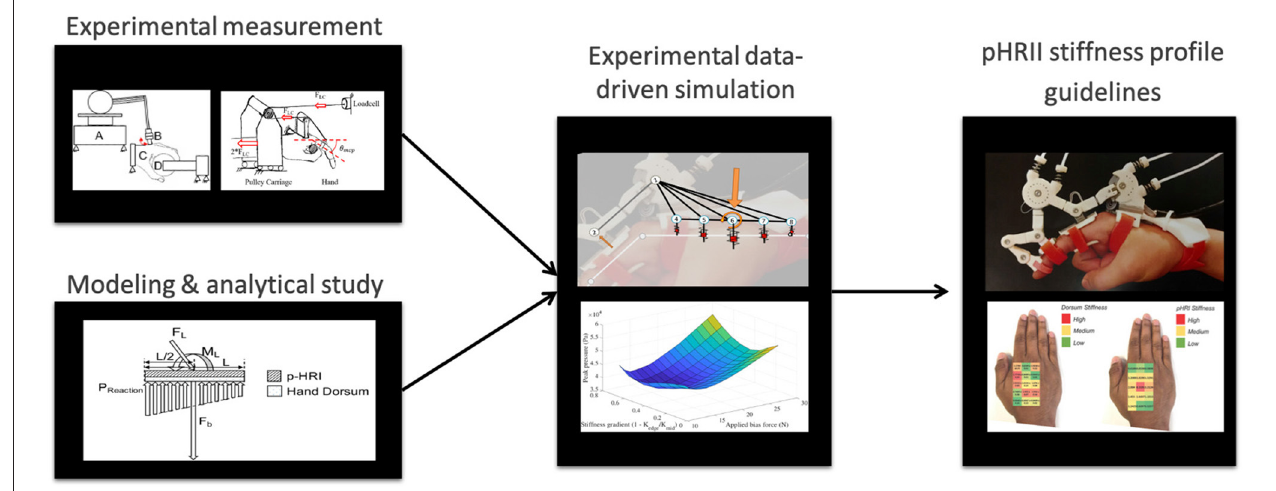
FIGURE 2 | A schematic of our methodology for optimizing the PHRII for the hand dorsum using a data-driven simulation